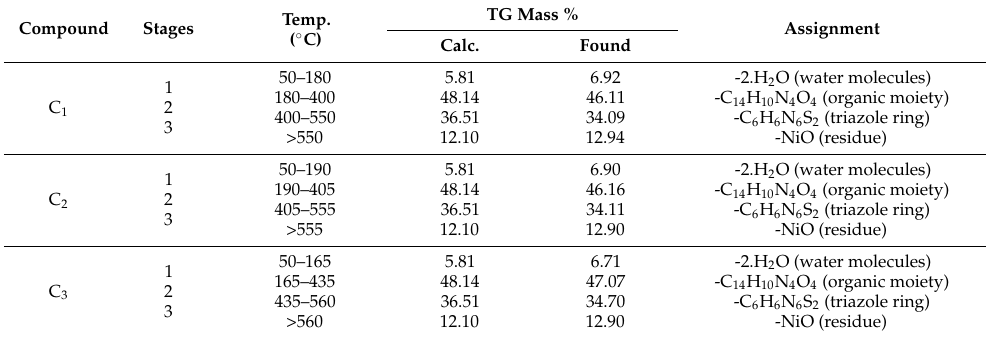
Table 4. Stepwise thermal degradation of metal complexes (C 1 –C 3